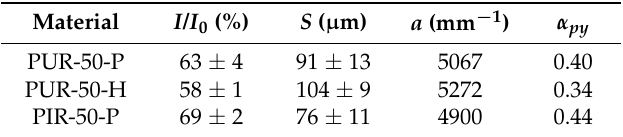
Figure 3. SEM micrograph of a cross section of struts and cell walls for PUR-50-P, PUR-50-H, and PIR-50-P as well as corresponding pyrolysis zones. Table 5. Measured intensities ( I / I 0 ), sample thicknesses ( S ), absorption coefficients ( a ), and absorptance of pyrolysis zone ( α py ) for every foam with a density of 50 kg/m 3